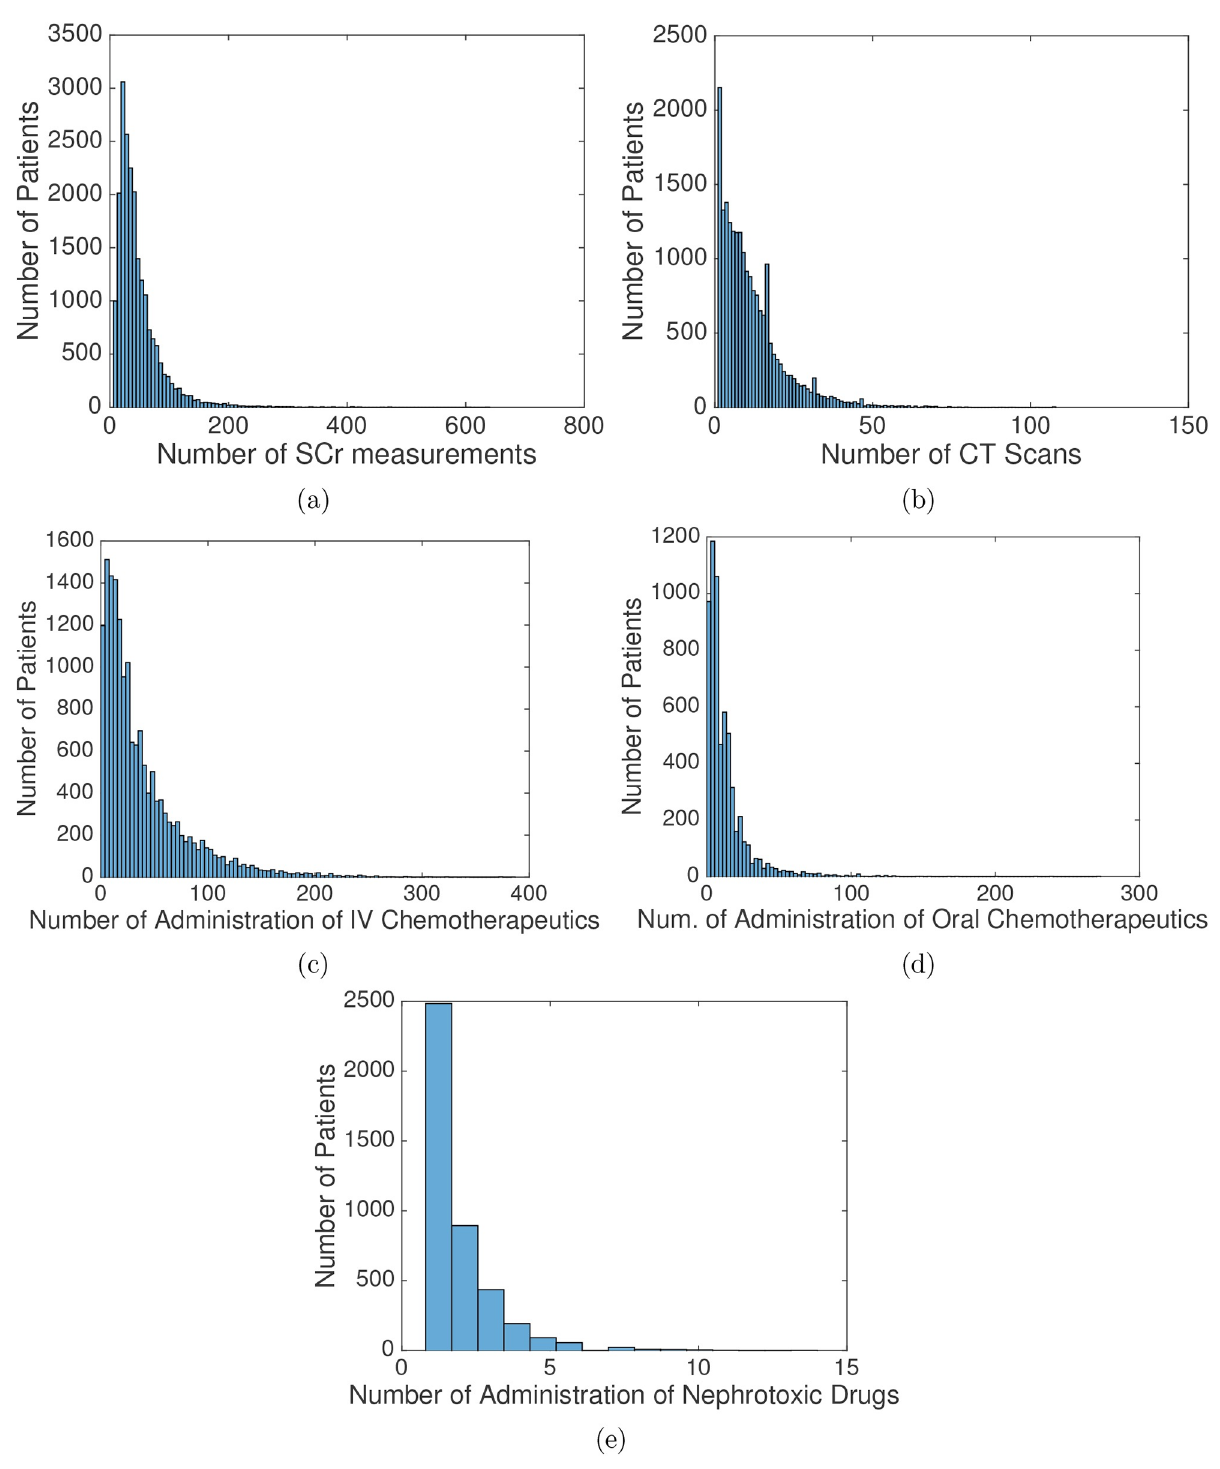
Fig 3. Distribution of number of temporal records. (a) Serum Creatinine (SCr) measurements, (b) CT scans, (c) administration of intravenous (IV) chemotherapeutics, (d) administration of oral chemotherapeutics, and (e) administration of nephrotoxic drugs.